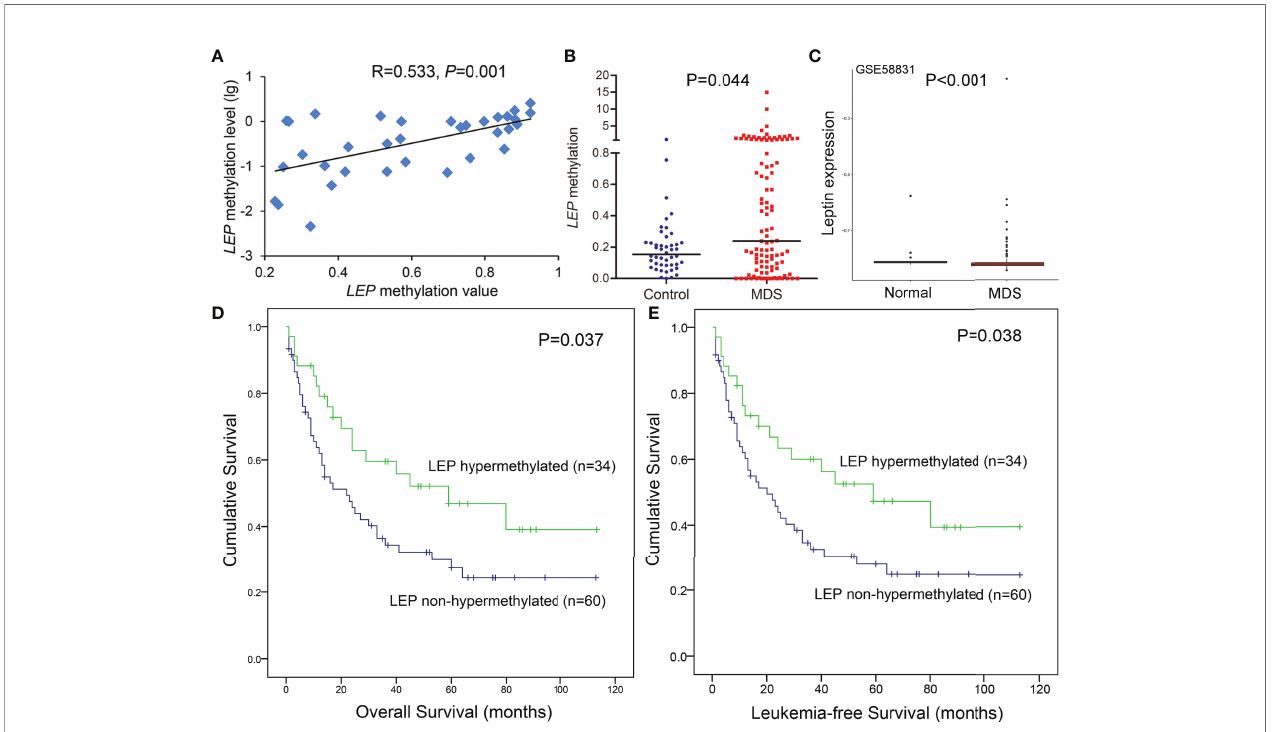
FIGURE 4 | Further con fi rmation of LEP methylation in MDS patients together with its prognostic value. (A) The correlation of LEP methylation results between the targeted bisul fi te sequencing and RQ-MSP. The correlation was analyzed by Spearman correlation test. (B) The methylation level of the LEP in larger samples of controls (n = 46) and de novo MDS (n = 105) and AML patients (n = 170) analyzed by RQ-MSP. P-values were calculated using the Mann – Whitney U-test. (C) Leptin expression in MDS patients from public GEO datasets. (D, E) The impact of LEP methylation on overall survival and leukemia-free survival of MDS patients. Survival was analyzed though Kaplan – Meier analysis using Log-rank test.